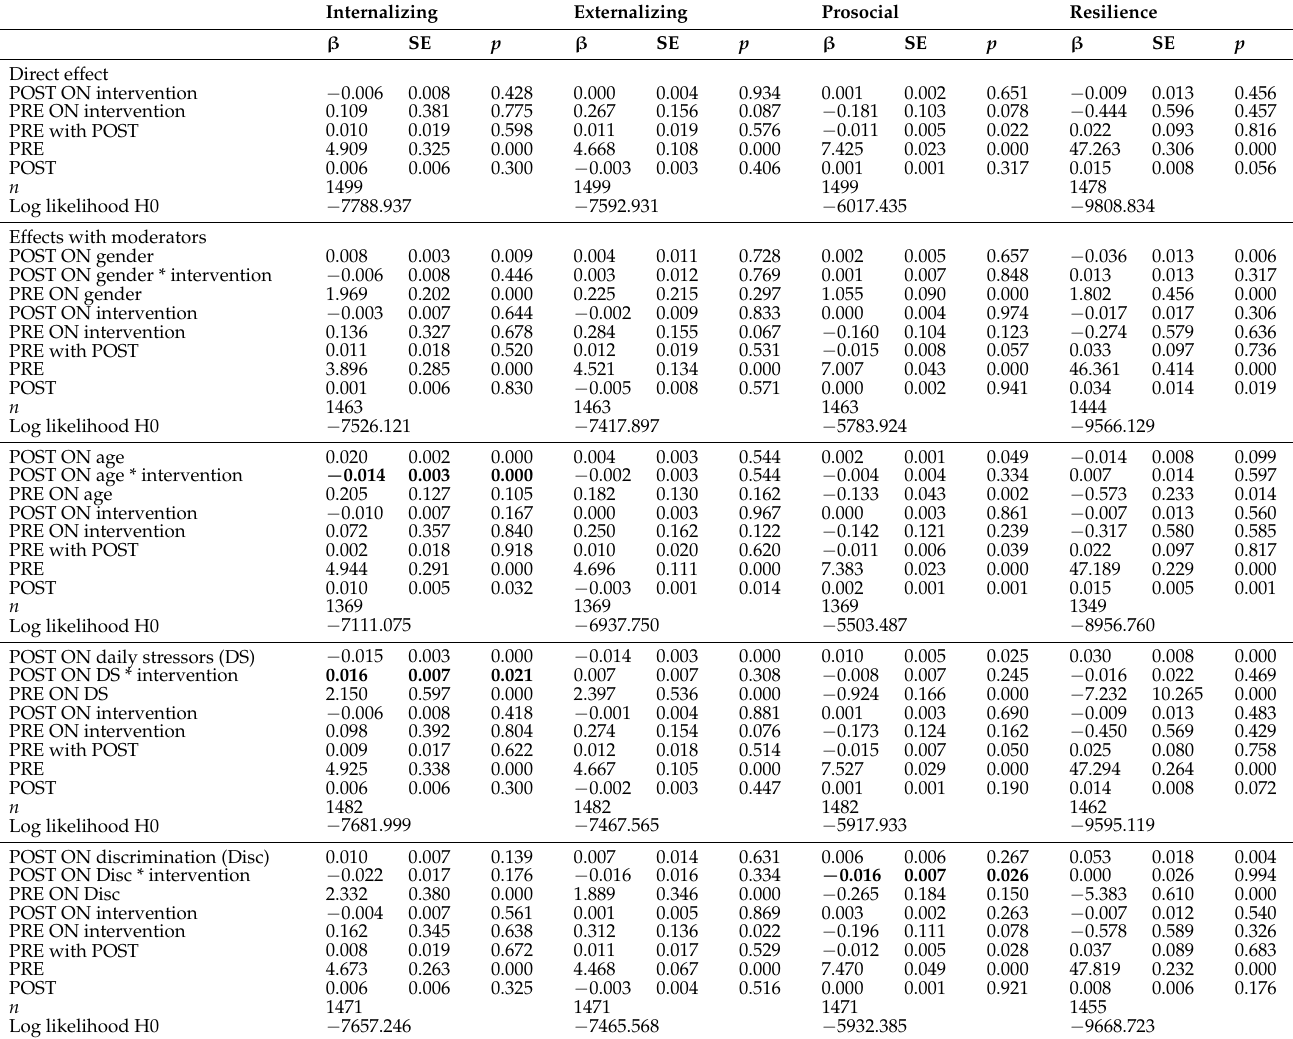
Table 4. Latent growth models for Finnish-born students regarding INSETT